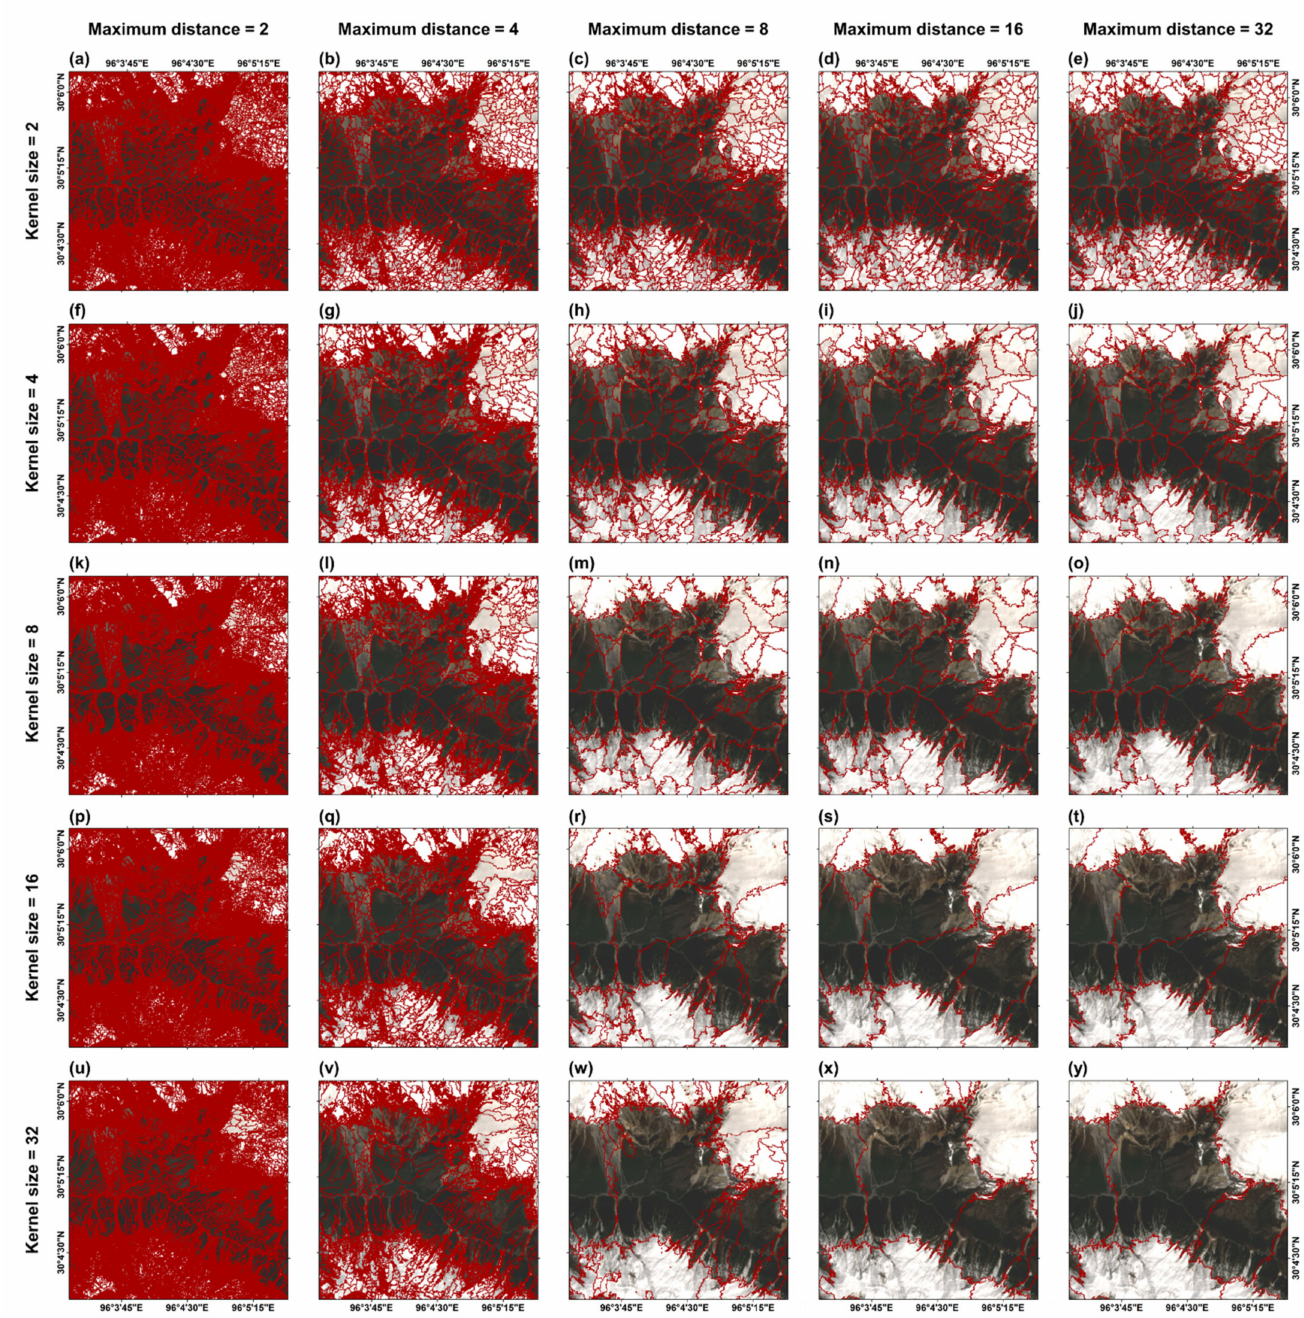
Figure 5. Influence of different segmentation parameters in a subarea of the training zone. (Segmented objects are delineated in red